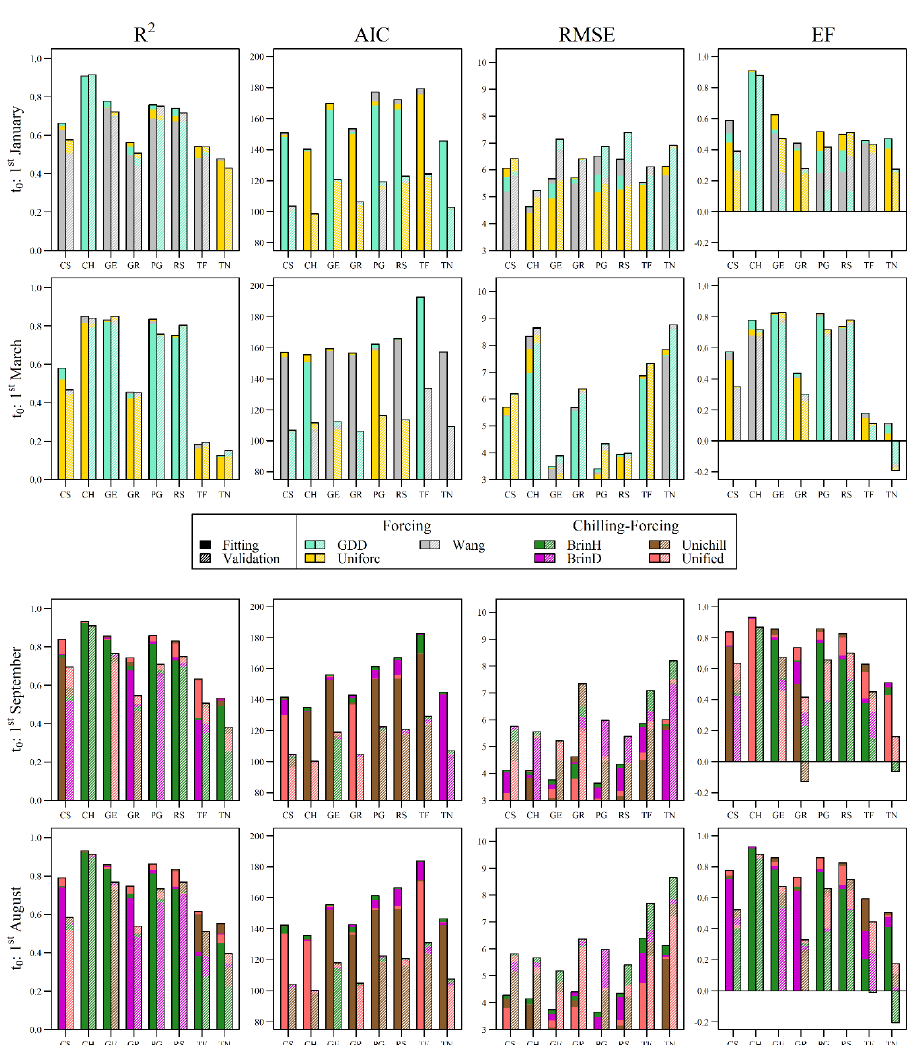
Figure 3. Statistical performances (R 2 , AIC, RMSE, EF) of all combinations of the six phenological models, eight grapevine varieties and different starting dates during fitting and validation. The results of forcing (F) and chilling-forcing (CF) models (different bar colours) are displayed at the top and bottom of the figure, respectively. The two bars identify the model fitting (no bar texture) and validation (line bar texture). CS = Cabernet Sauvignon, CH = Chardonnay, GE = Gewürztraminer, GR = Grenache, PG = Pinot Gris, RS = Riesling, TF = Touriga Franca, TN = Touriga Nacional.